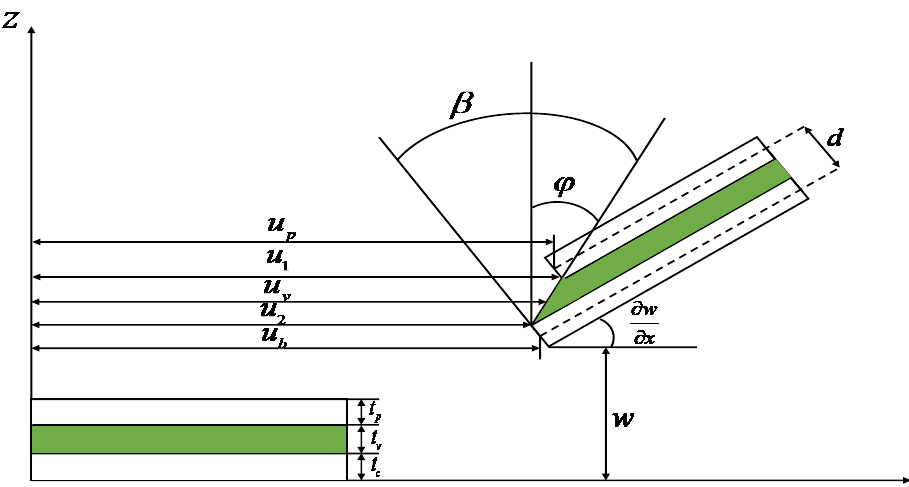
the corner of the ACLD beam.